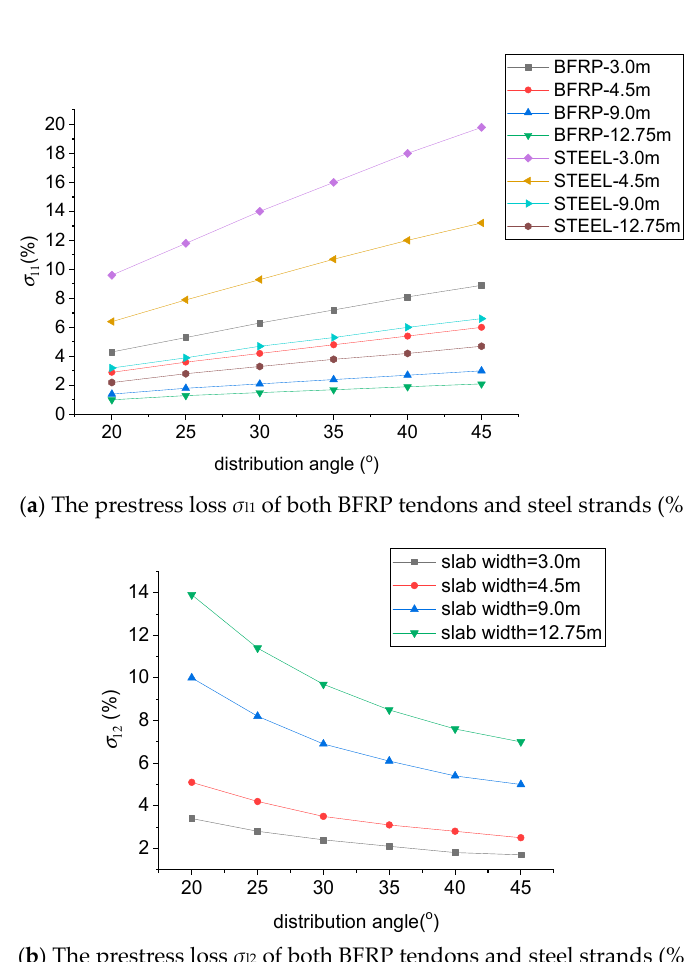
Figure 2. Comparison of prestress loss of BFRP tendons and steel strands during the in-service stage at various slab widths and distribution angles (%). 4.3.3. Total Prestress Loss As shown in Figure 3, for a specific slab width (3.0 m, 4.5 m, 9.0 m, and 12.75 m) and distribution angle (20°, 25°, 30°, 35°, 40°, and 45°) of the prestressed tendon, the total prestress loss of the BFRP tendon was always lower than that of the steel strand. The difference between the two prestress losses